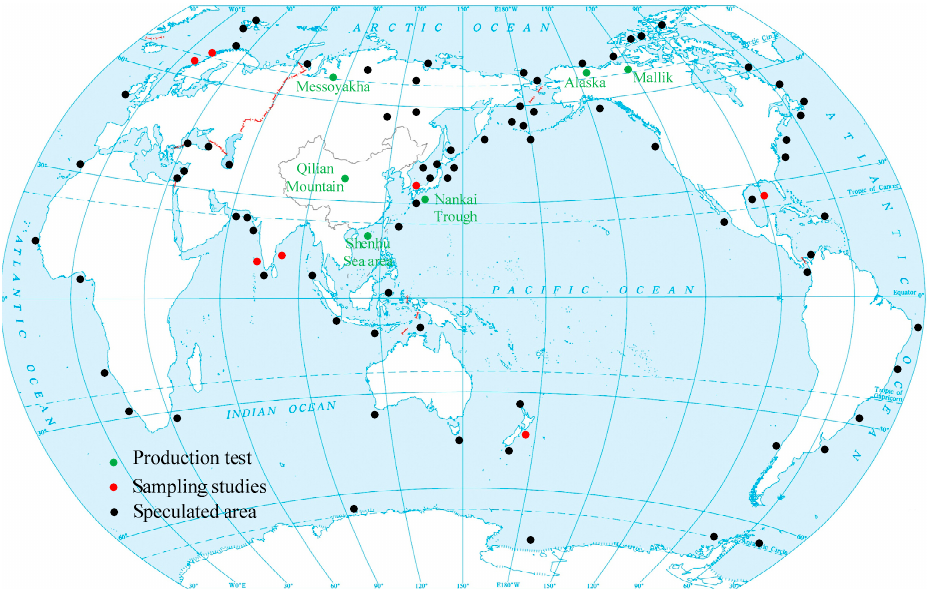
Figure 1. Distribution of NGH deposits on Earth [8]. (1) “Production test” represent the places where have been successfully tested NGH production; (2) “Sampling studies” represent the places just where the hydrate samples are taken but not production tested; (3) “Speculated area” represent the places where there may be hydrates under current prospecting technique.